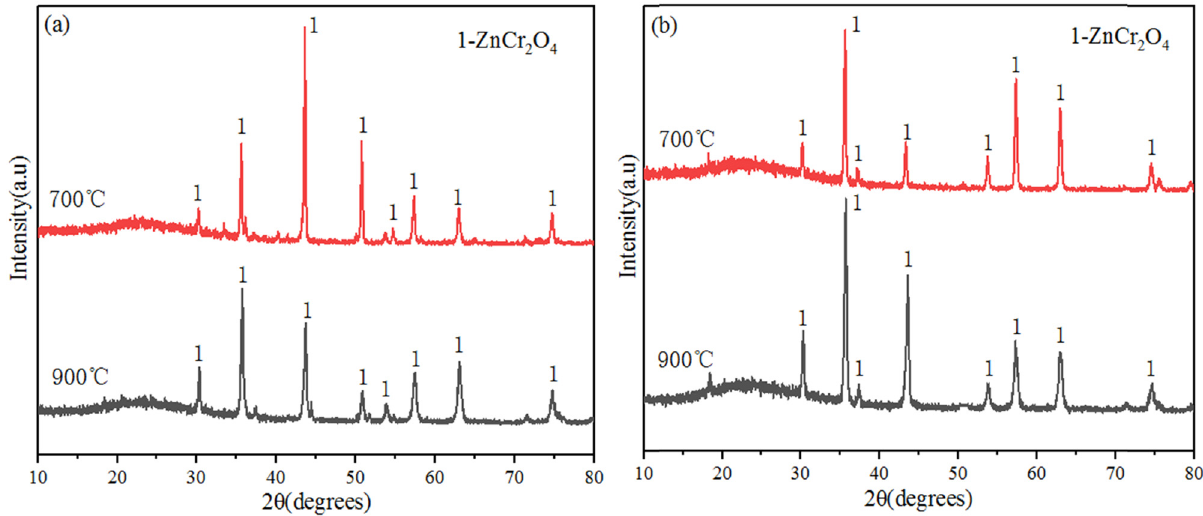
Figure 6: XRD patterns of the corrosion products formed during the corrosion process in ternary chloride molten salt at 700°C and 900°C on the surface of ( a ) 316 ss and ( b ) Inconel 625 alloy